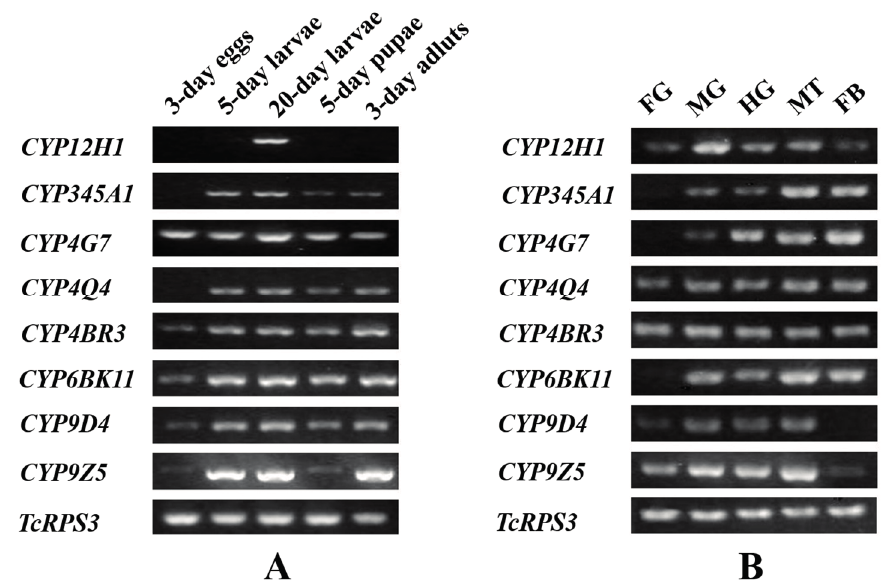
Figure 2. Stage-dependent ( A ) and tissue-dependent ( B ) expression patterns of eight selected CYP genes in T. castaneum (Georgia-1 strain). The expression profiles were evaluated by reverse transcription PCR (RT-PCR). The expression patterns of five different tissues, including foregut (FG), midgut (MG), hindgut (HG), Malpighian tubules (MT), fat bodies (FB) were derived from 20-day larvae, and TcRPS3 was used as an internal reference